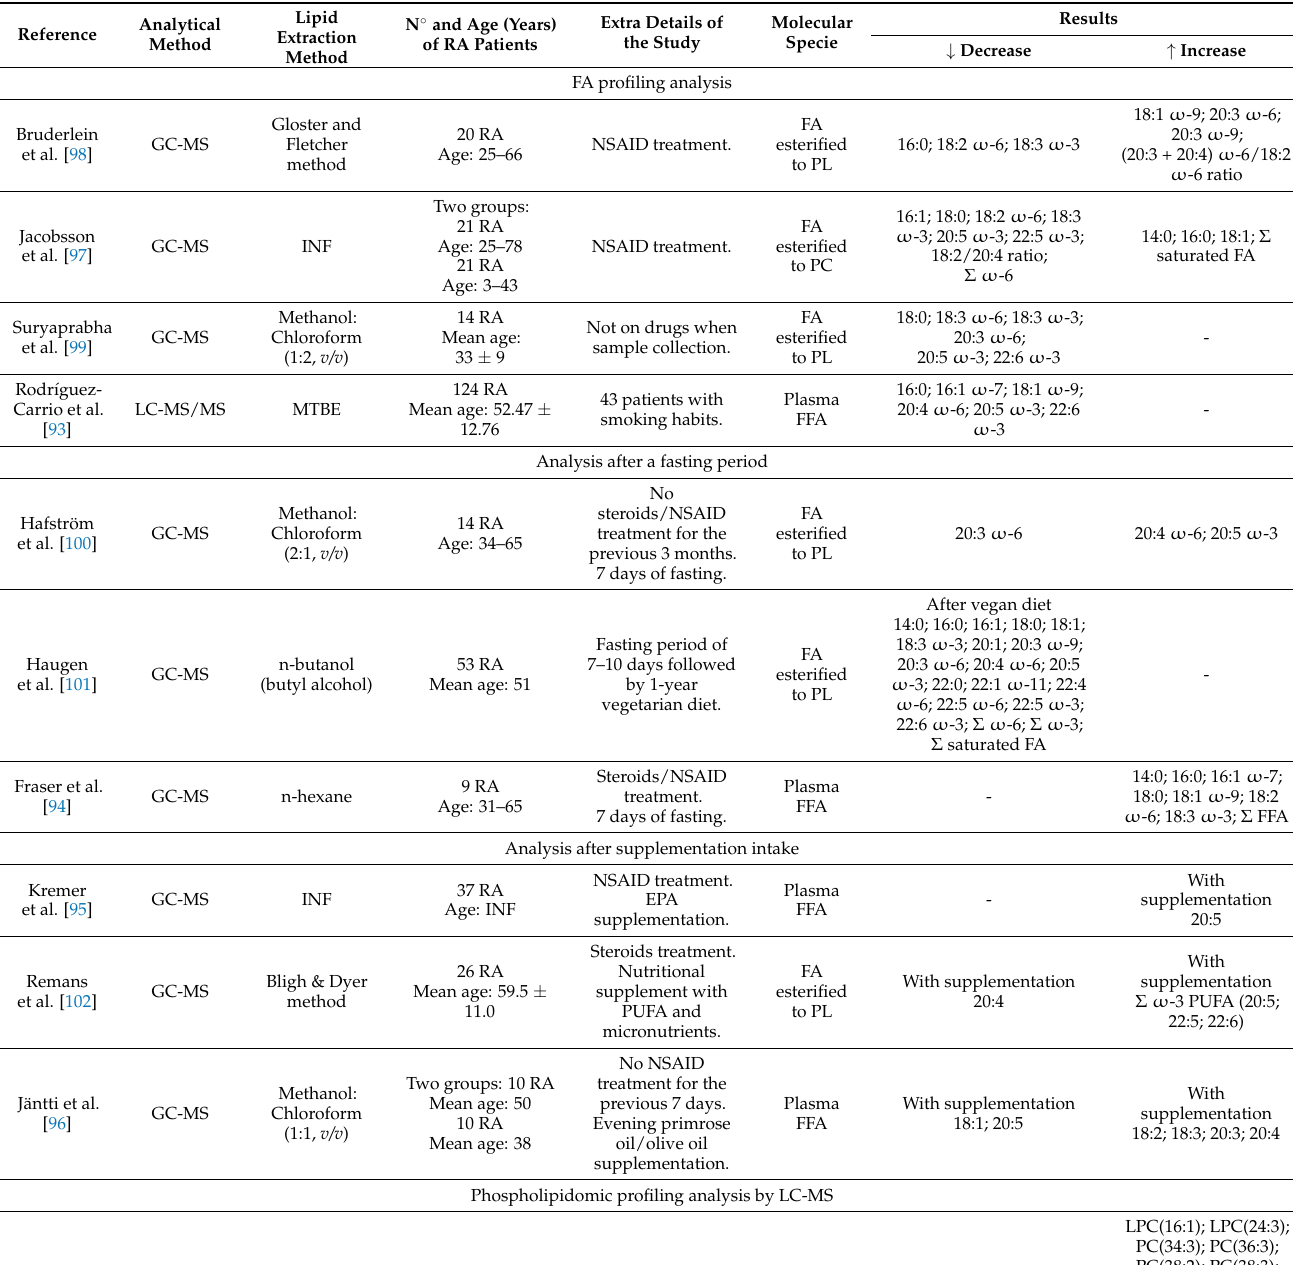
Table 1. Main lipid variations observed in serum/plasma of RA patients reported in published lipidomic studies, available in PubMed database, using MS